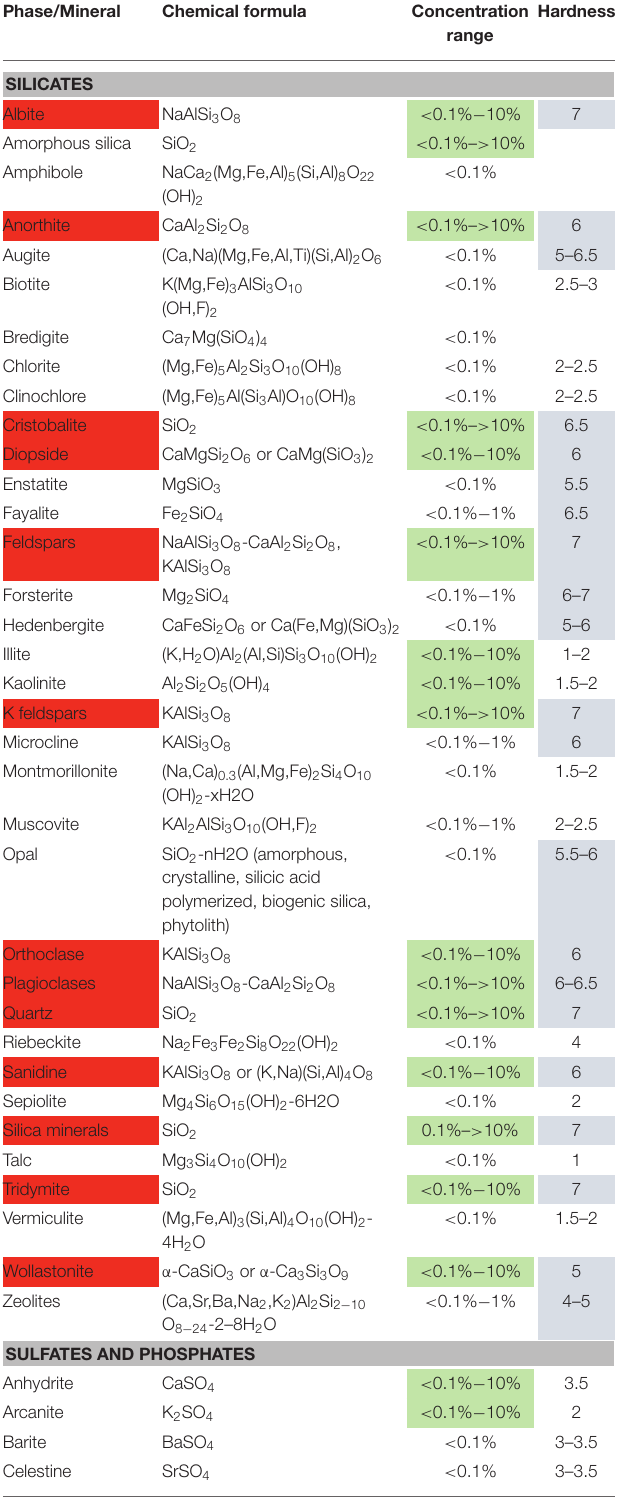
TABLE 2 | Mineral compounds found in biomass [Adapted from (Vassilev et al., 2013), hardness values obtained from the “Minerology Database (10) (http://